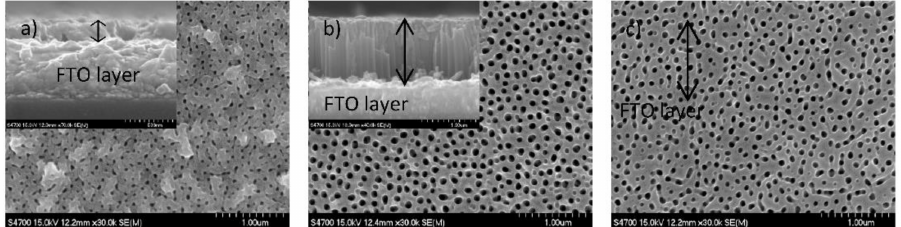
Figure 9. SEM images of TNTs grown onto FTO (inset: cross section image) by the anodization of Ti films of thickness of: ( a ) 100 nm; ( b ) 600 nm; and ( c ) 1000 nm. Reprinted from reference [1] under license CC